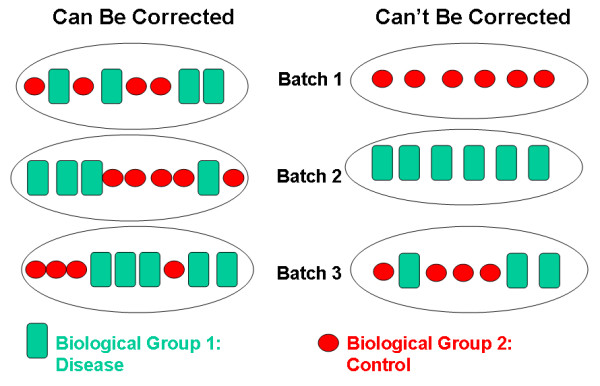
Batch processing of microarray samples from different biological groups. Examples of experimental designs that can be corrected for batch effects (left panel) and cannot be corrected for batch effects (right panel).